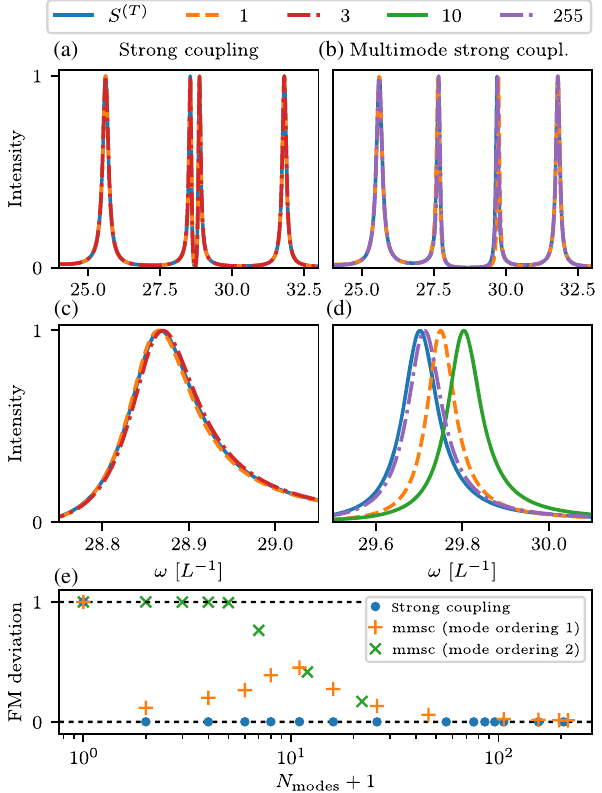
FIG. 9. Convergence behavior of the few-mode expansion in the strong coupling (a),(c) and multimode strong coupling (b),(d) regimes. (a) – (d) show few-mode spectra at different numbers of ∈ f 1 ; 3 ; 10 ; 255 g ; see the legend). The system modes ( N modes solid blue line shows linear dispersion spectra as a benchmark ( S ð T Þ ). In the strong coupling case, the convergence is fast, with a single mode being sufficient (c), as expected. At multimode strong coupling, the qualitative behavior is already captured in a single-mode description, but for quantitative agreement more than 100 modes of the generic mode basis are necessary (d). The convergence in the two cases can be quantified by the few-mode (FM) deviation Eq. (89). (e) shows this quantity as a function of 1 ). The strong coupling case (blue the mode number ( N modes þ dots) shows the expected behavior. In the multimode strong coupling case (mmsc, orange crosses, green hatches), the con- vergence is much slower, and, for low mode numbers, the convergence depends on the order in which the modes are added to the few-mode system space, as explained in the main